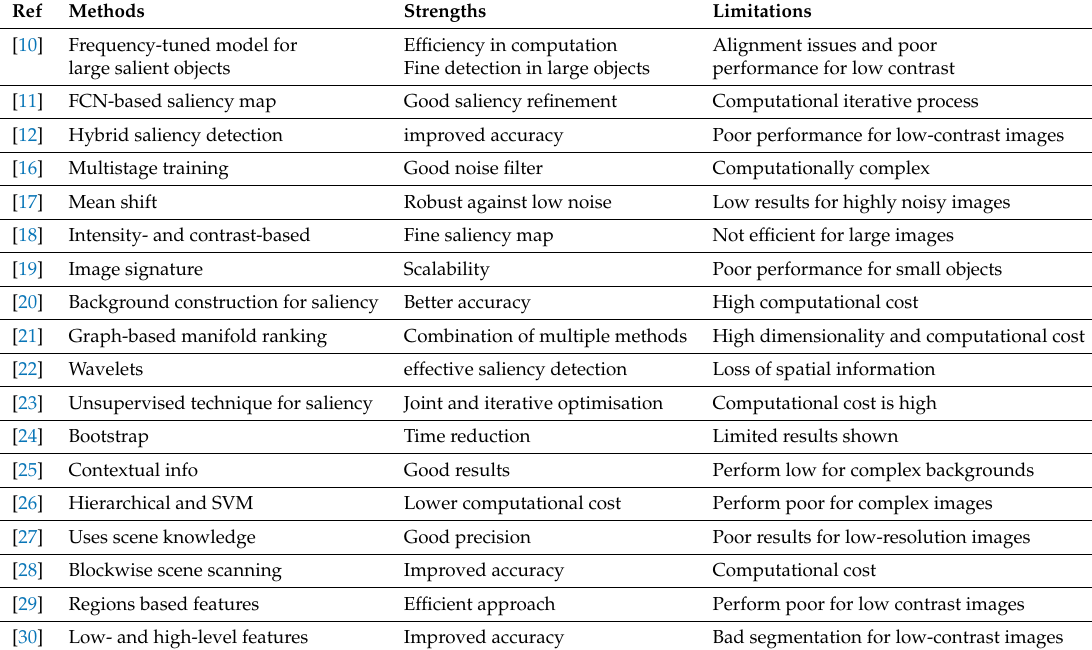
Table 1. Summary of related-work